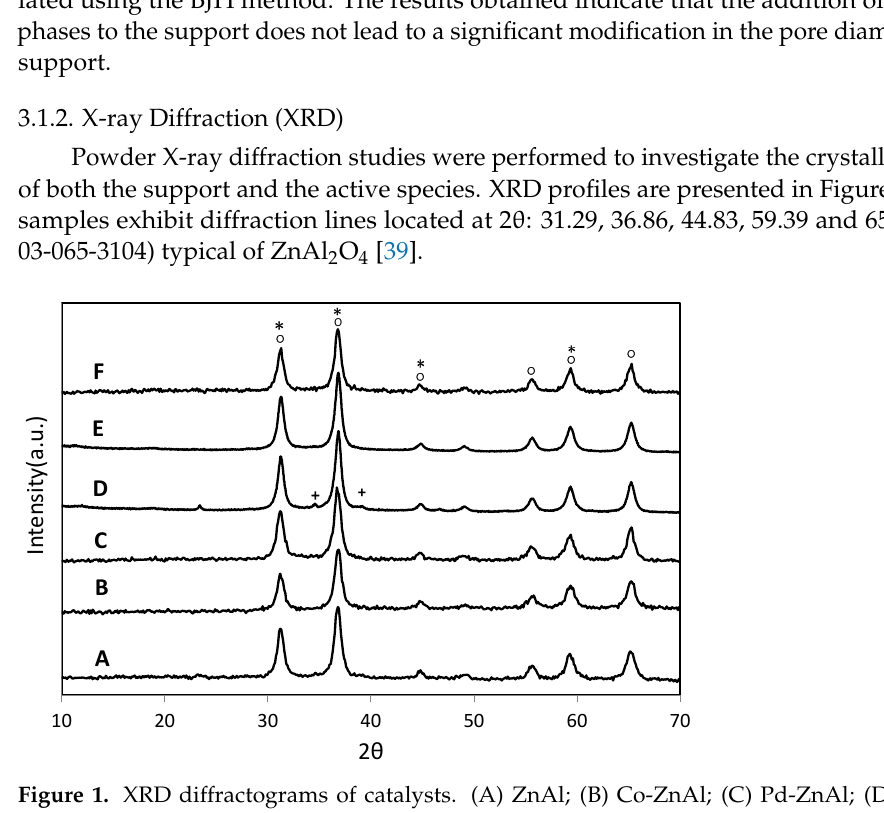
(2 θ = 39.7, 46.5 and 67.9 ◦ , JCPDS N ◦ 05–0681). These last diffraction lines cannot be